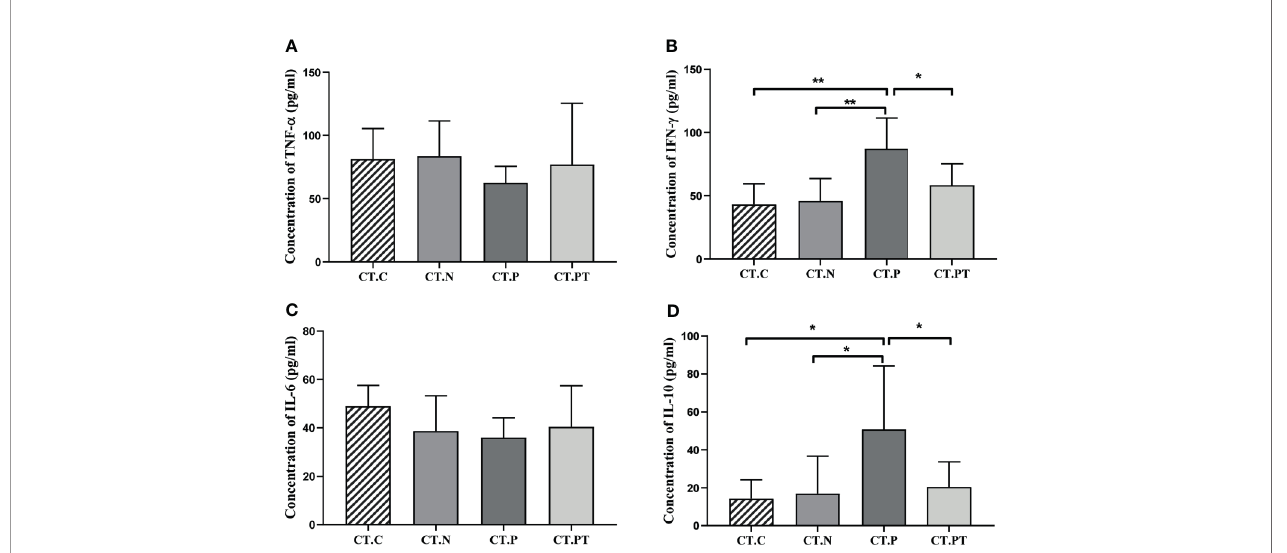
FIGURE 1 | Cytokine production in vaginal secretions in each group. (A) Tumor necrosis factor (TNF)- a , (B) interferon (IFN)- g , (C) interleukin (IL)-6, and (D) IL-10 levels were detected in vaginal discharge samples using ELISA kits. Each bar represents the mean ± SD of the cytokine levels (pg/ml). *p < 0.05 and **p < 0.01. CT- C, women from the physical examination center (PEC) who were healthy and C. trachomatis -negative; CT-N, women who were infertile and C. trachomatis -negative from the assisted reproductive technology center (ART); CT-P, women who were infertile and C. trachomatis -positive from the ART; CT-PT, CT-P women post- treatment with